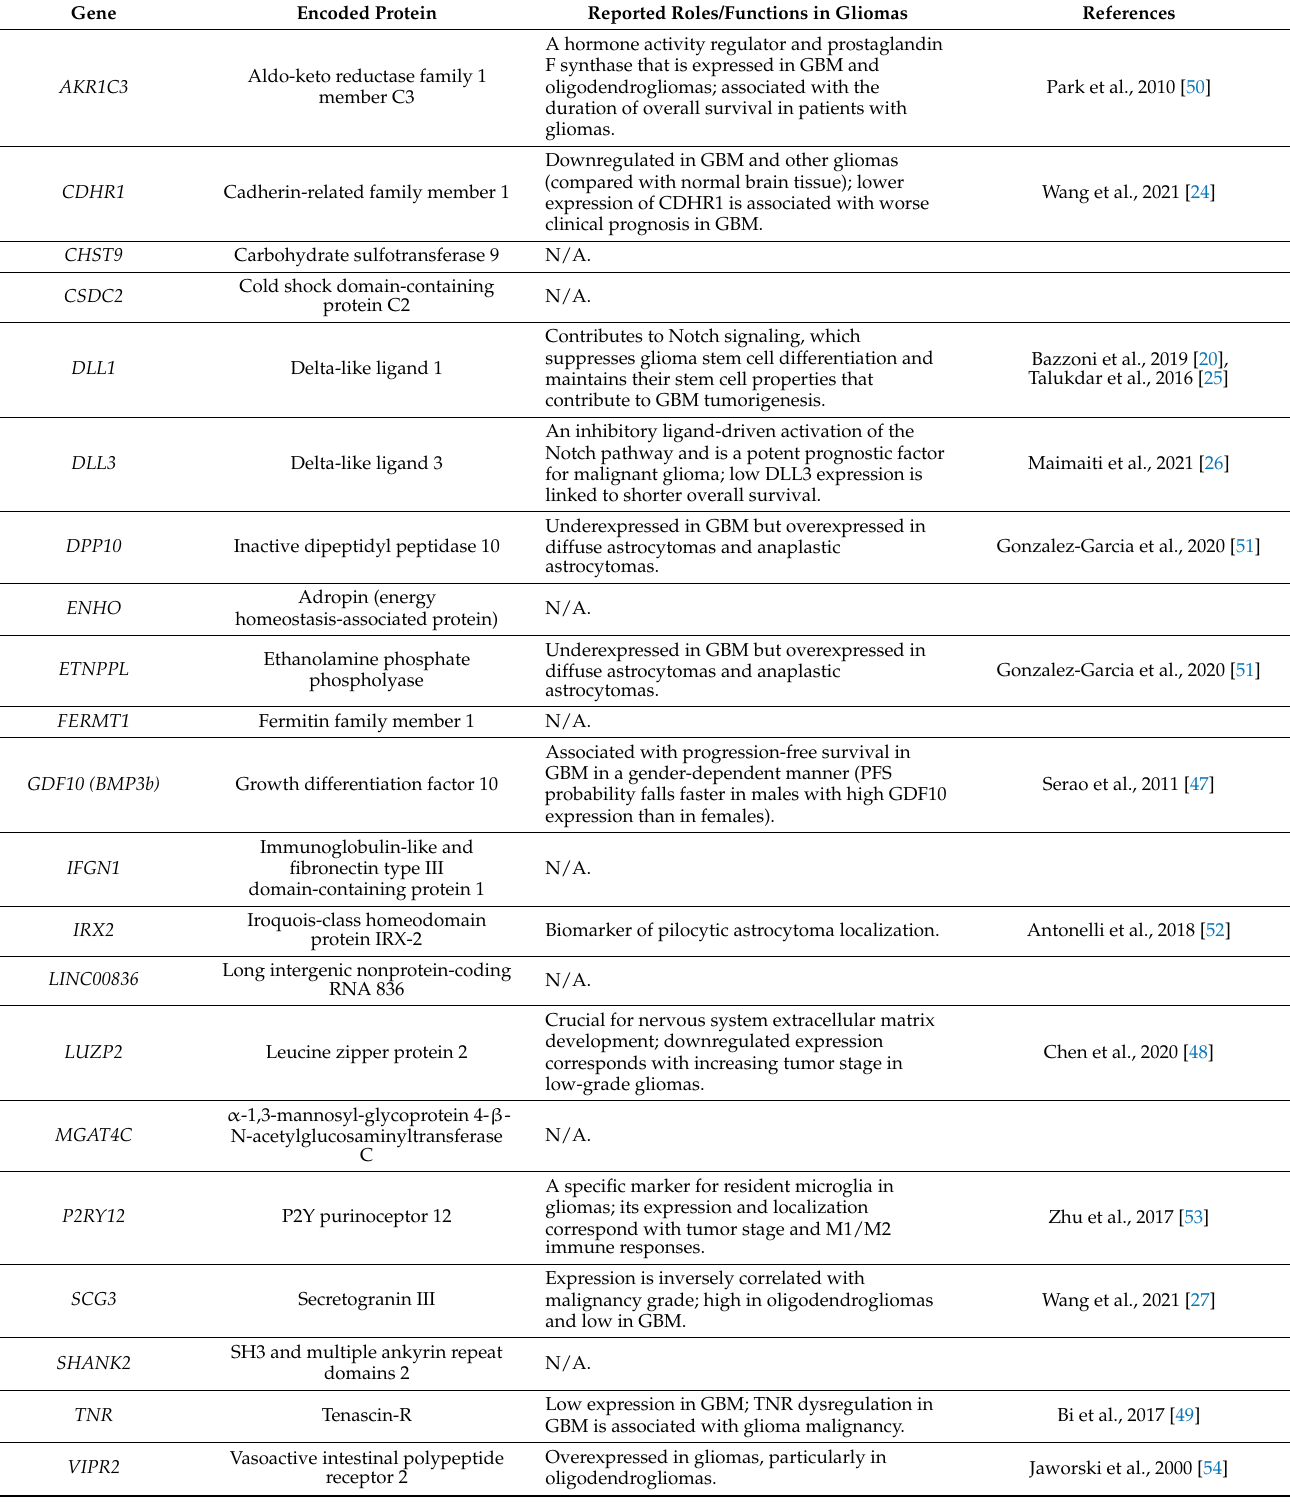
Table 4. Roles/functions of the underexpressed GBM gene signatures in